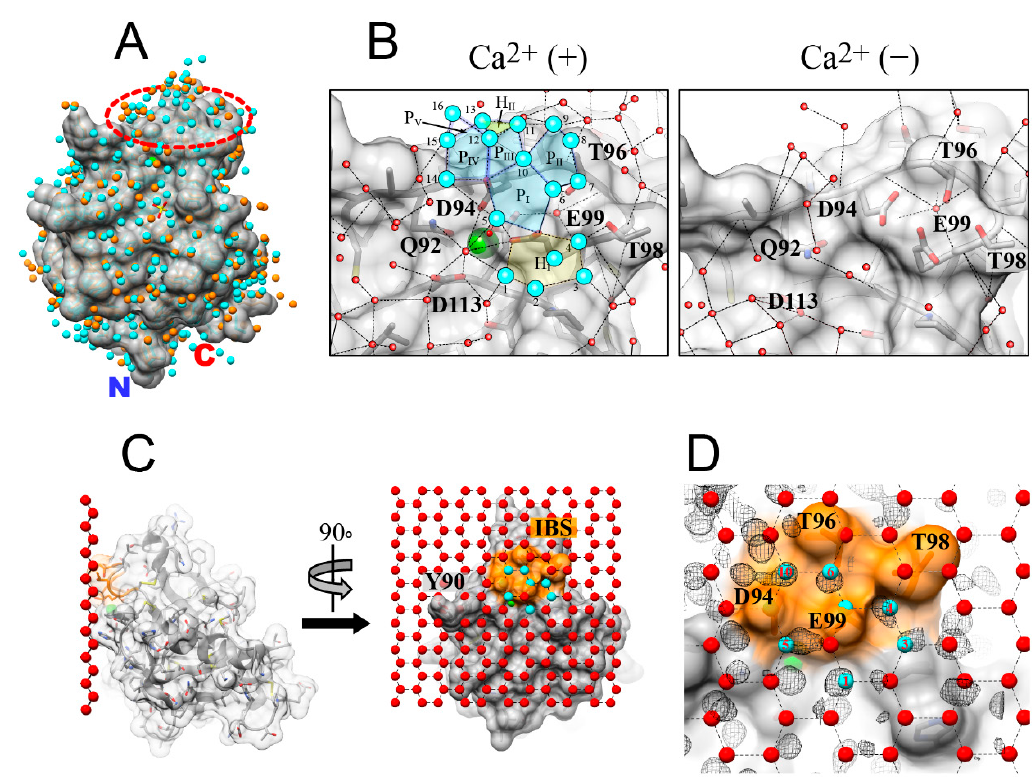
Figure 5. Ice-like semi clathrate waters located on the Ca 2 + -binding site. ( A ) Hydration waters located on the Ca 2 + -bound (cyan) and -free (orange) structures of jsAFP. The two structures are superimposed perfectly as their backbone conformation is highly similar to each other. An approximate position of the Ca 2 + -binding site functioning as IBS is indicated by a red hatched circle. ( B ) Polypentagonally arranged ice-like waters located on the Ca 2 + -binding site of jsAFP. The hydration waters are shown as red spheres, and those involved in the polypentagonal networks are represented by blue spheres. A total of five pentagonal waters (P I –P V ) and one hexagonal waters (H I ) are constructed on the Ca 2 + -bound structure of jsAFP, while not on the Ca 2 + -free structure. ( C ) Manual docking of the jsAFP structure to 1st prism plane of a single ice crystal. The oxygen atoms (red) of 1st prism plane perfectly fit to the Ca 2 + -binding site of jsAFP (left). The waters involved in the pentagonal network (blue) on the putative ice-binding residues (orange) share the positions of the oxygen atoms (red) constructing the ice plane (right). ( D ) An expanded view of the putative IBS docked with oxygen atoms constructing the 1st prism plane. The number labeled on the ice-like water (cyan) is the same as that labeled in ( B ). These waters (cyan) seem to be located in the clefts created between the ice-binding residues (D94, T96, T98, and E99).